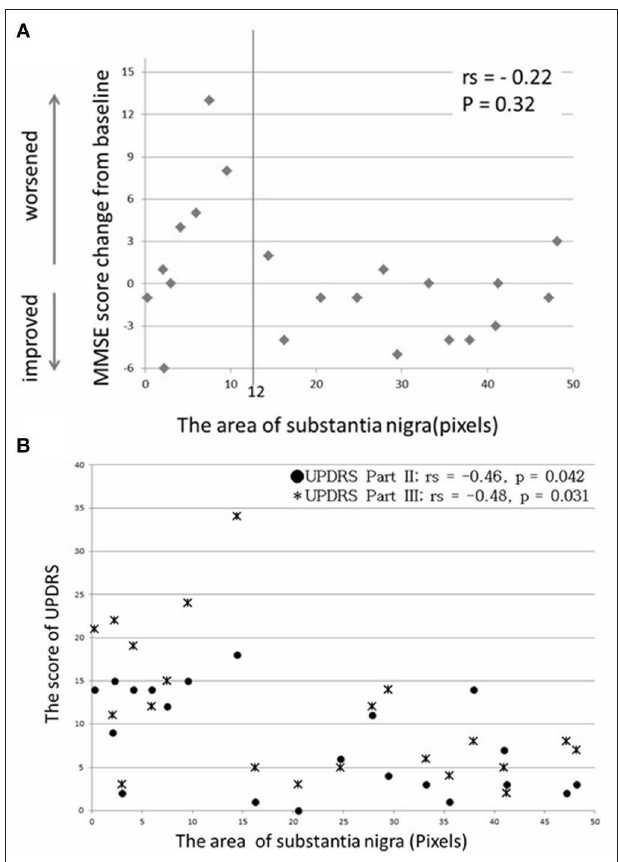
FIGURE 3 | No significant correlation was found between SN area and MMSE score change (A) , and a moderate correlation was found between SN area and UPDRS score 1 year postoperatively (B)